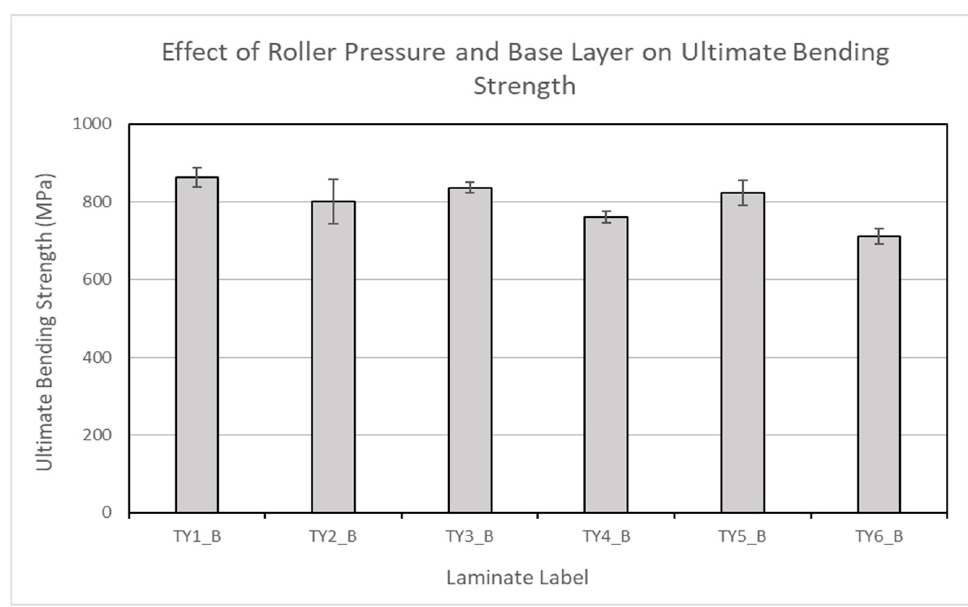
Figure 22. Effect of roller pressure and base layer on ultimate bending strength for all laminates.